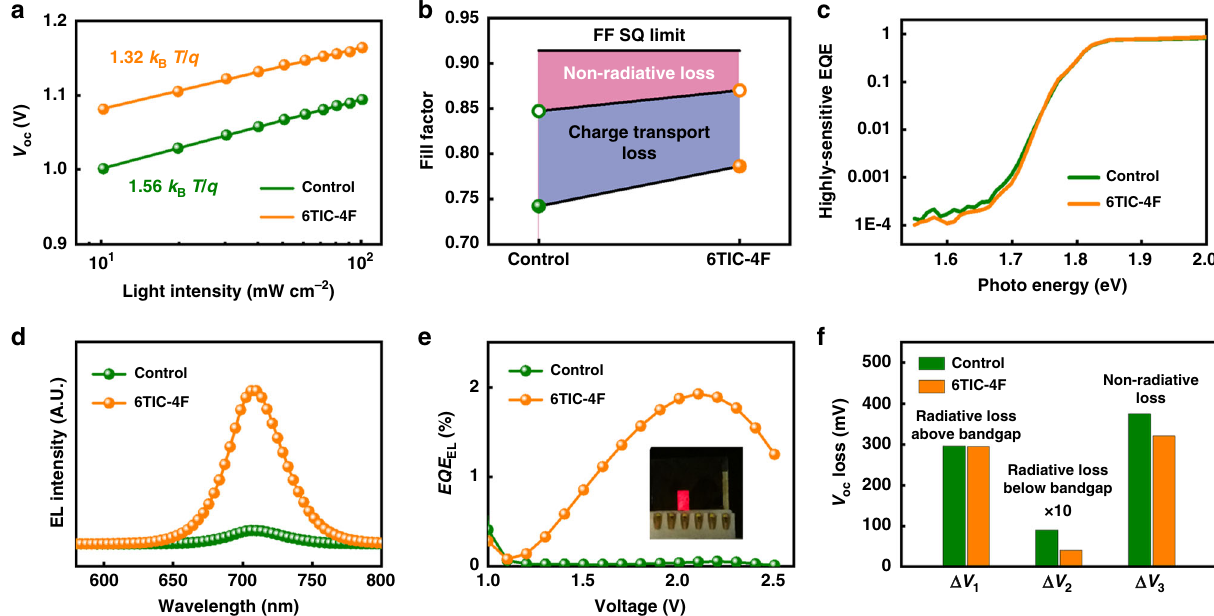
Fig. 4 Device physics and recombination process. a The plot of light intensity dependent V OC of the studied devices. b The device FF limitation is composed of non-radiative loss (pink area) and charge transport loss (blue area). The solid and open circles stand for the measured FF and the maximum FF without charge transport loss, respectively. c The highly sensitive EQE of the studied PVSCs. d EL spectra of the studied PVSCs operating as LEDs. e EQE of EL of the PVSCs working in LEDs mode under different voltage, inset: LED working image. f The radiative and non-radiative V OC loss of the studied